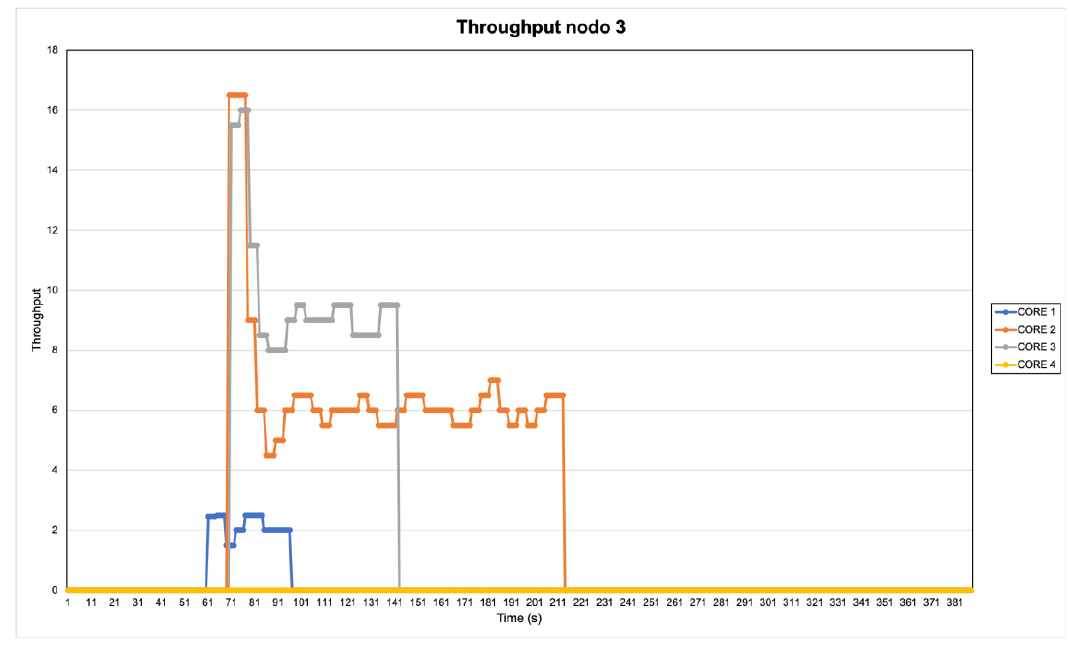
Figure 17. RPI node 3 power consumption.